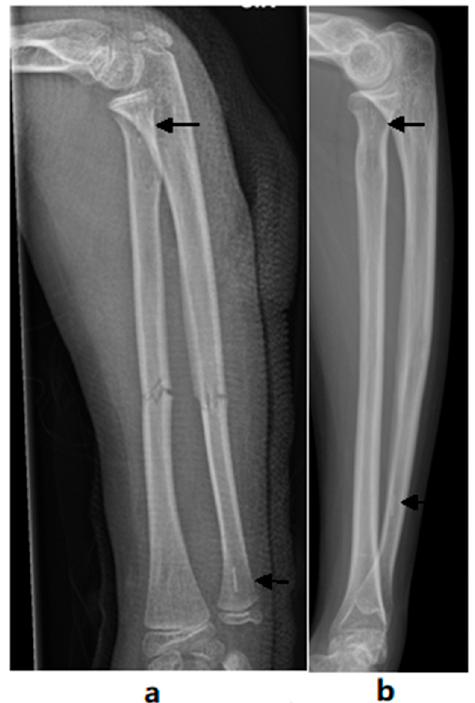
Figure 4. Forearm radiographs with radiolucent β -TCP-tips (black arrows) of the biodegradable nails immediately after operation ( a ) and 6.6 years after operation ( b